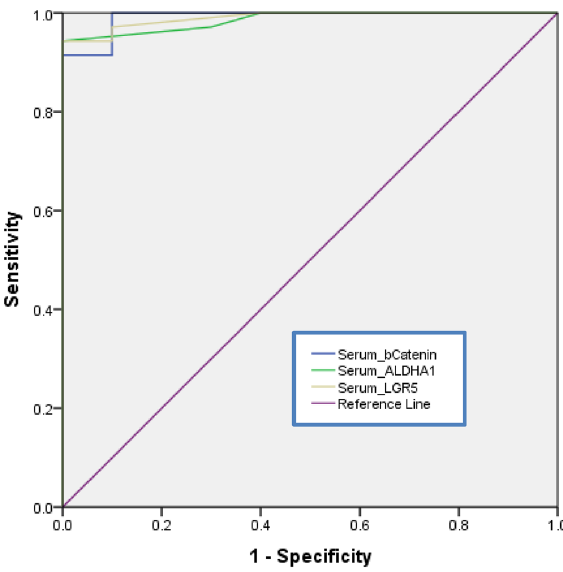
Figure 8. Graphical presentation of the ROC curve for serum ALDH1A1, serum LGR5 and serum β-catenin in breast cancer